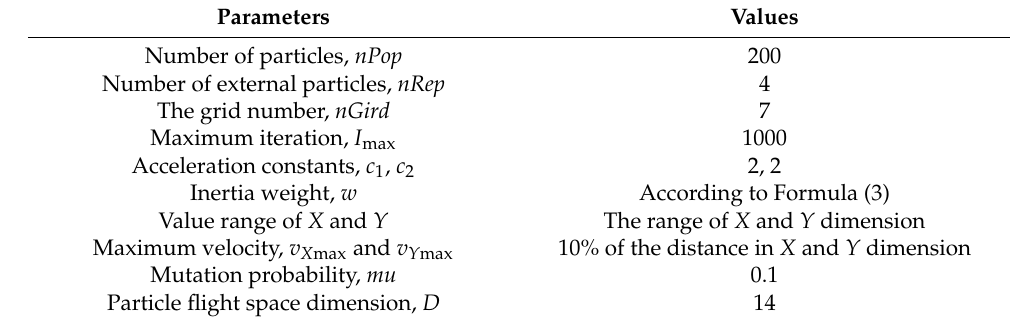
Table 1. Parameter settings of MOPSO. Parameters Values Number of particles, nPop 200 Number of external particles, nRep 4 The grid number, nGird 7 Maximum iteration, I max 1000 Acceleration constants, c 1 , c 2 2, 2 Inertia weight, w According to Formula (3) Value range of X and Y The range of X and Y dimension Maximum velocity, v X max and v Y max 10% of the distance in X and Y dimension Mutation probability, mu 0.1 Particle flight space dimension, D